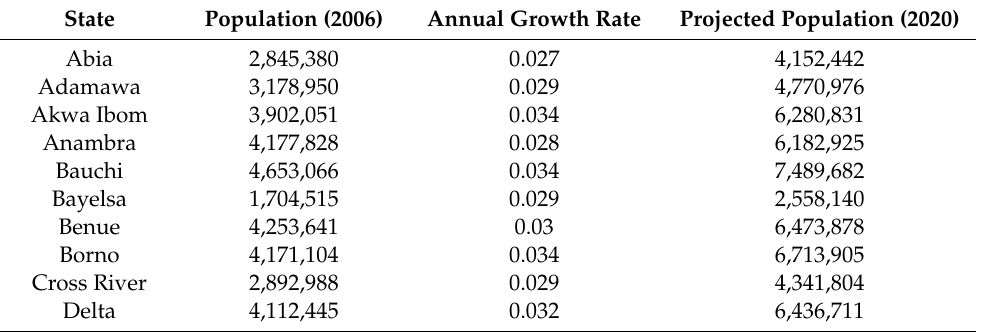
Table 1. The projected population for each state in Nigeria including the Federal Capital Territory (FCT) for the year